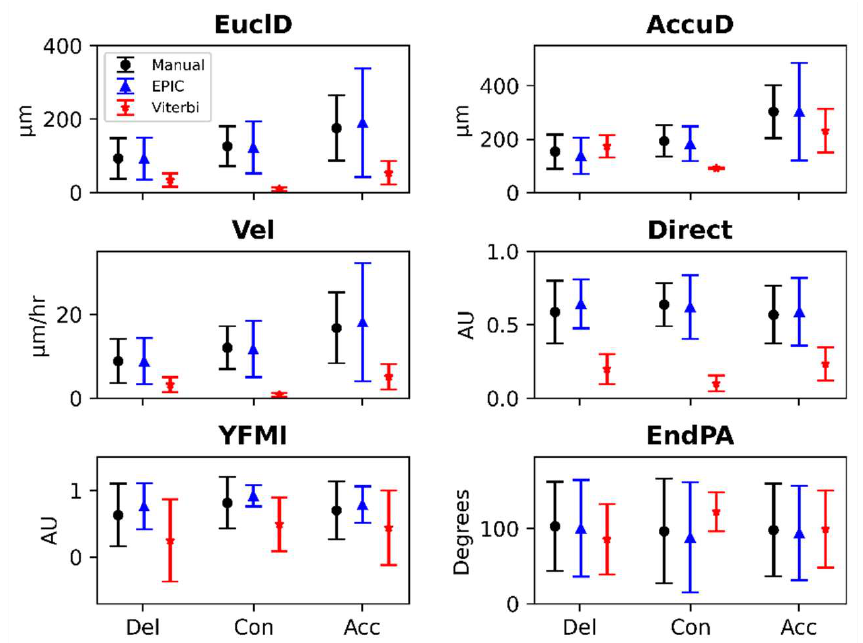
Figure 4. Cell migration metrics produced by manual cell tracking, EPIC and Viterbi. Various shapes and bars represent the mean and standard deviations, respectively, of cell migration metrics produced by manual (black circle), EPIC (blue triangle) and Viterbi (red star) cell tracking in delayed (Del), control (Con) or accelerated (Acc) experiments.